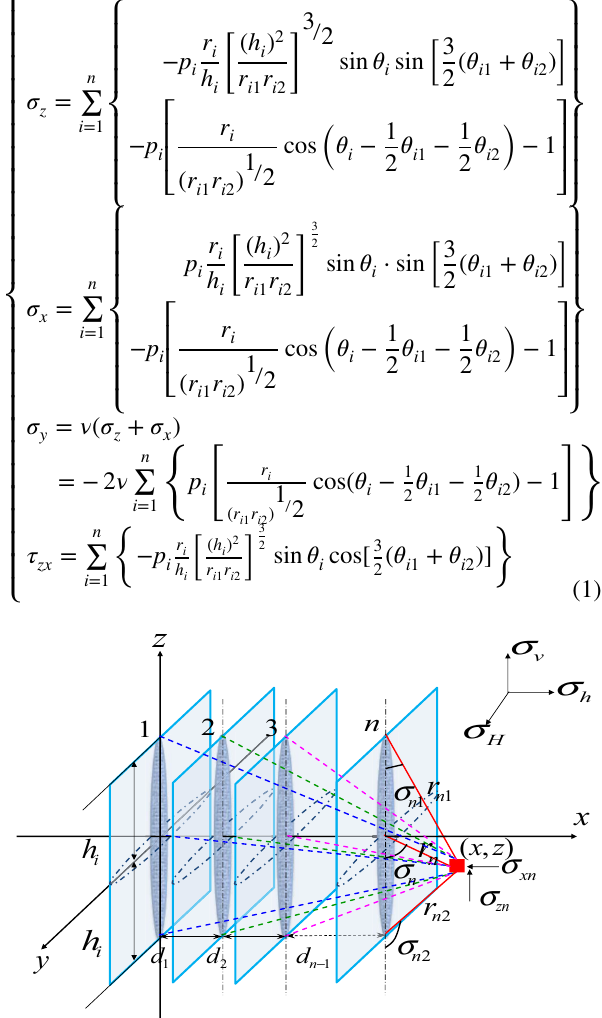
Fig. 1 Fracture-induced stress schematic